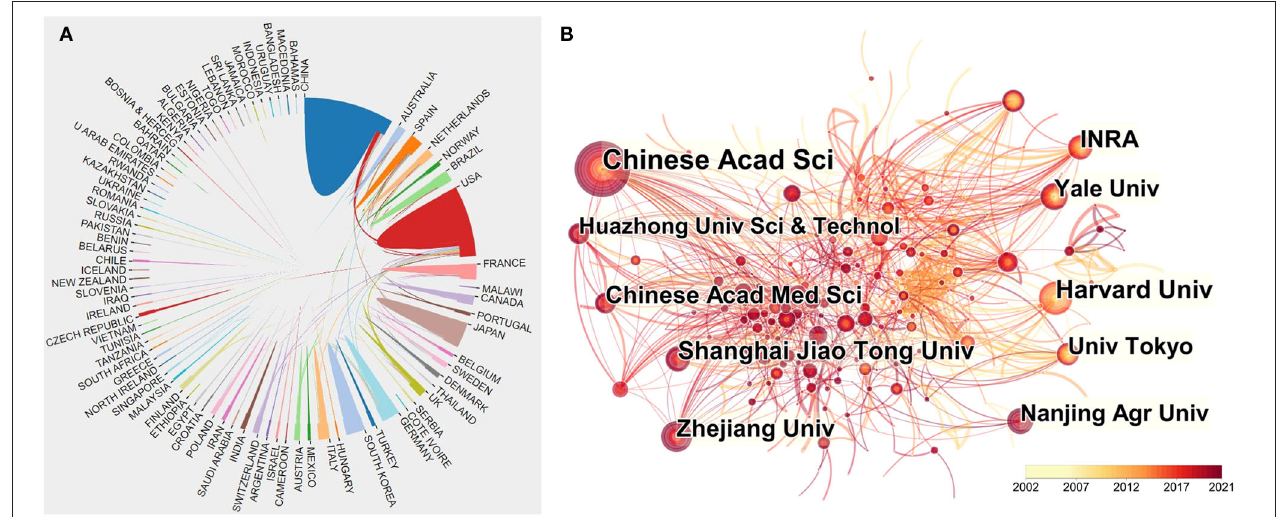
FIGURE 3 | (A) Cooperative relationships between 82 countries/regions on the topic of hepatic glycolipid metabolism from 2002 to 2021. Data were exported from the Online Analysis Platform of Literature Metrology. (B) The CiteSpace network map of institutions involved in hepatic glycolipid metabolism research. The top 10 most productive institutions are shown. The size of the concentric circle represents the number of articles published by each institution, and the thickness of the connecting lines indicates the degree of cooperation between institutions. The darker the color of the concentric circle is, the more productive the institution has been on hepatic glycolipid metabolism in recent